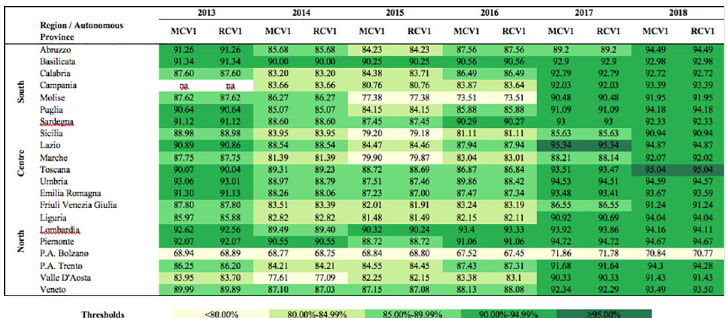
Fig 1. Vaccination coverage for measles- and rubella-containing vaccine first dose by Region, Italy, 2013–2018. MCV1 , measles-containing vaccine first dose; RCV1 , rubella-containing vaccine first